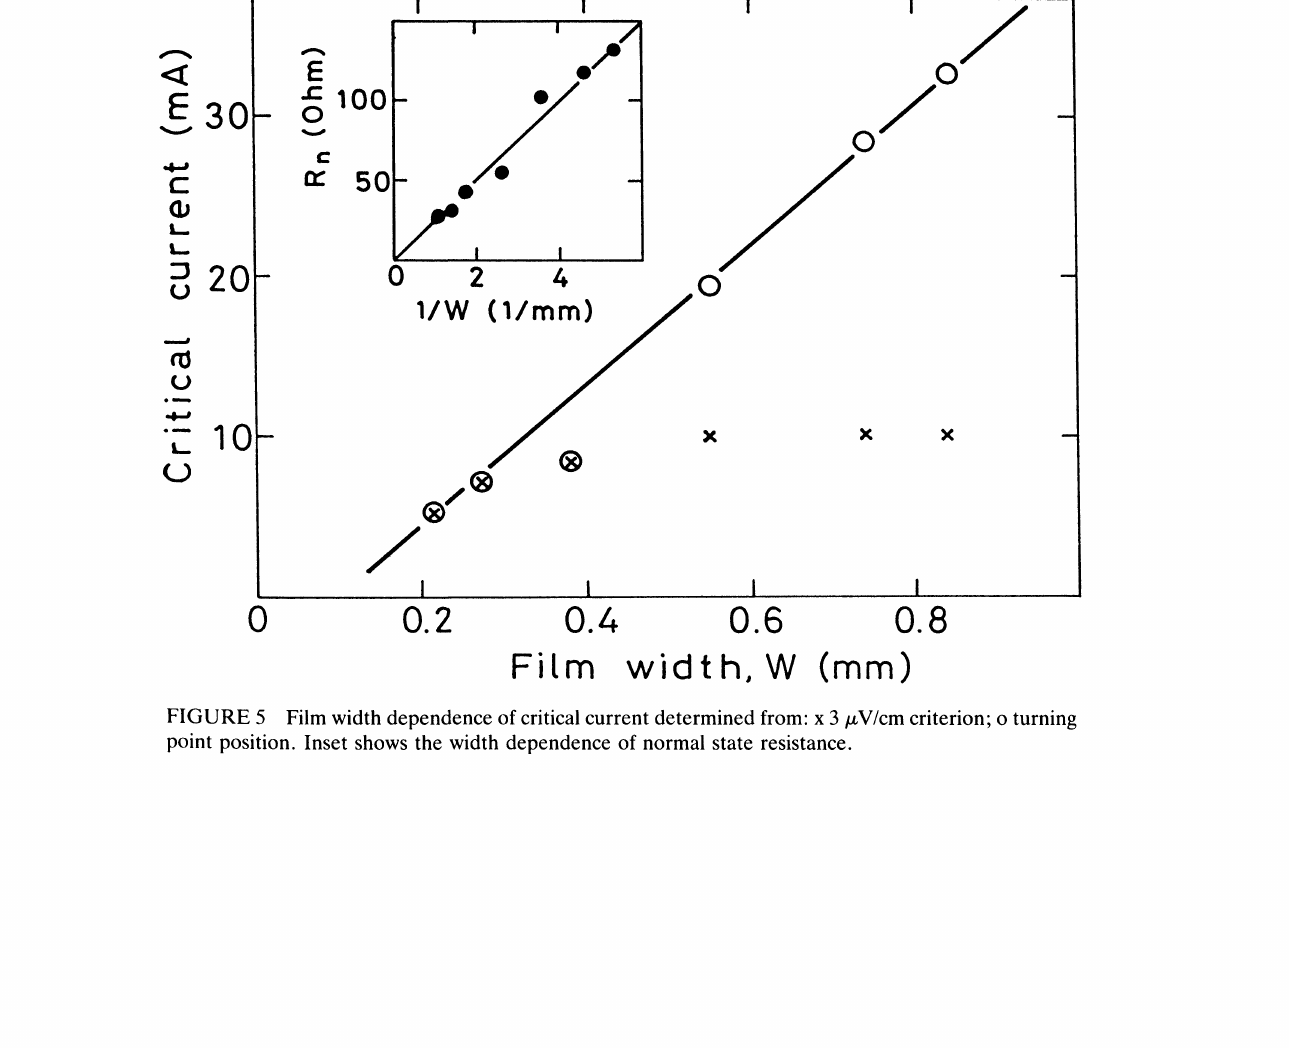
FIGURE 5 Film width dependence of critical current determined from: x 3/xV/cm criterion; o turning point position. Inset shows the width dependence of normal state